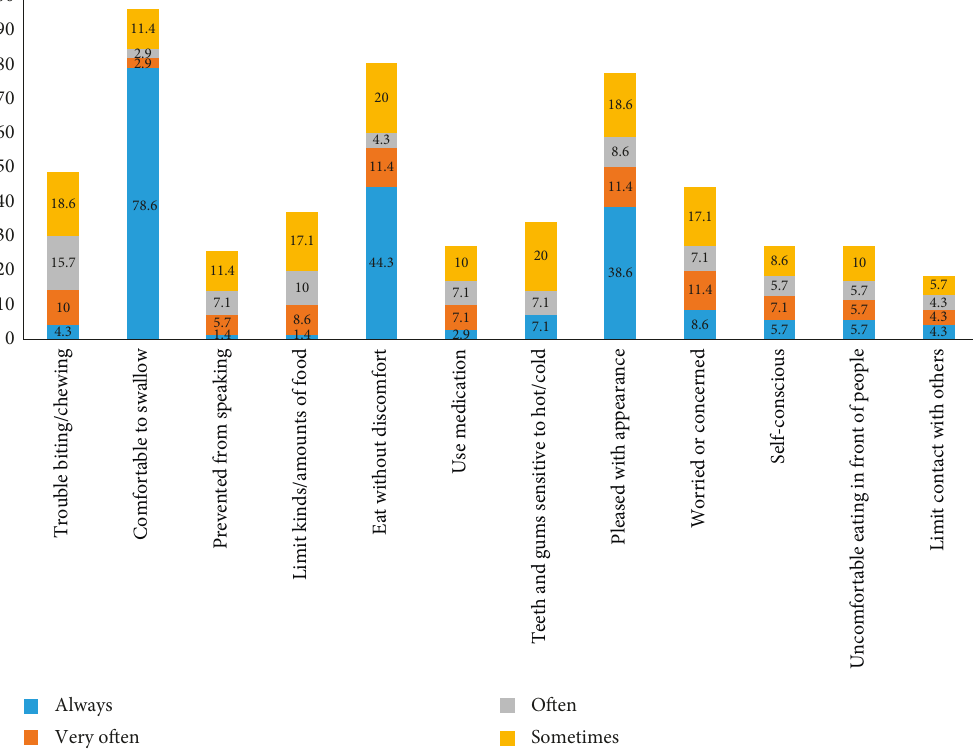
Figure 1: Percentage of participants responding always, very often, often, and sometimes to individual GOHAI-12 items ( N � 70)